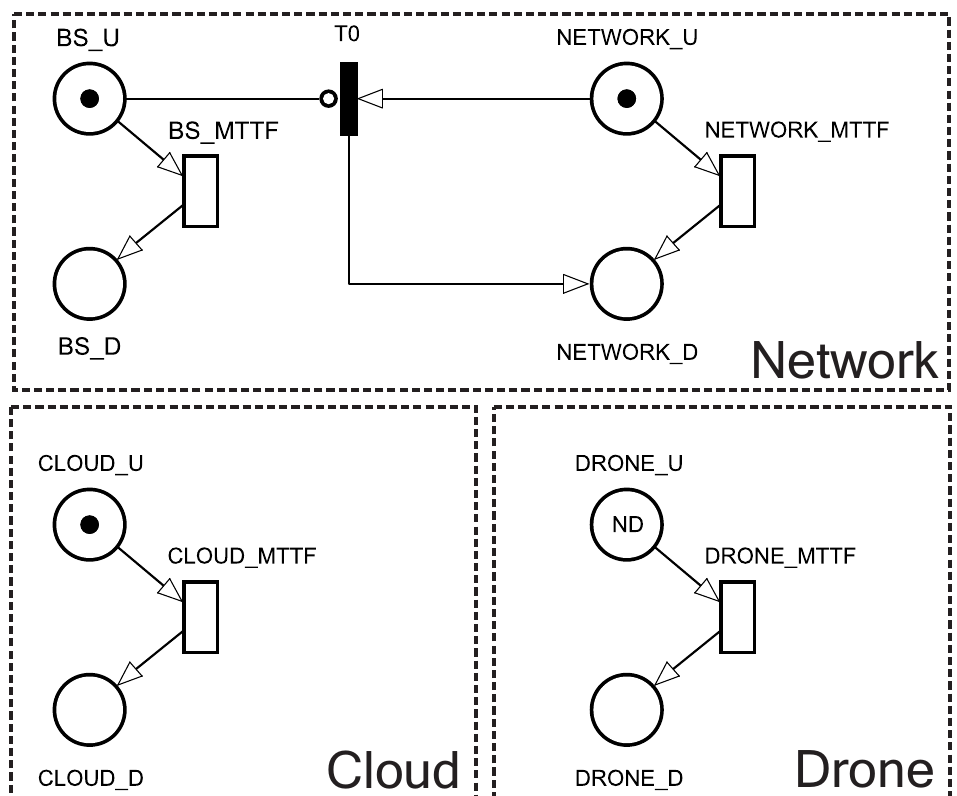
Figure 11. Reliability model based on the base model without recovery.